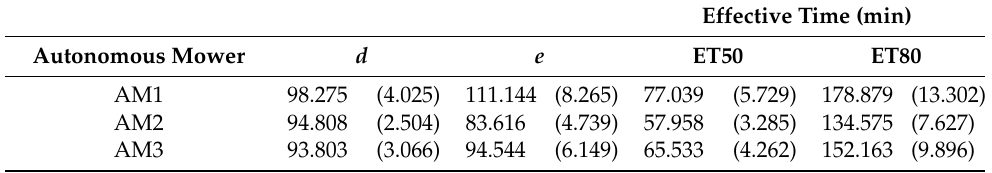
Table 3. Parameters of the nonlinear asymptotic regressions (2) and effective mowing times of each autonomous mower estimated from the two-stage meta-analysis dose-response model.